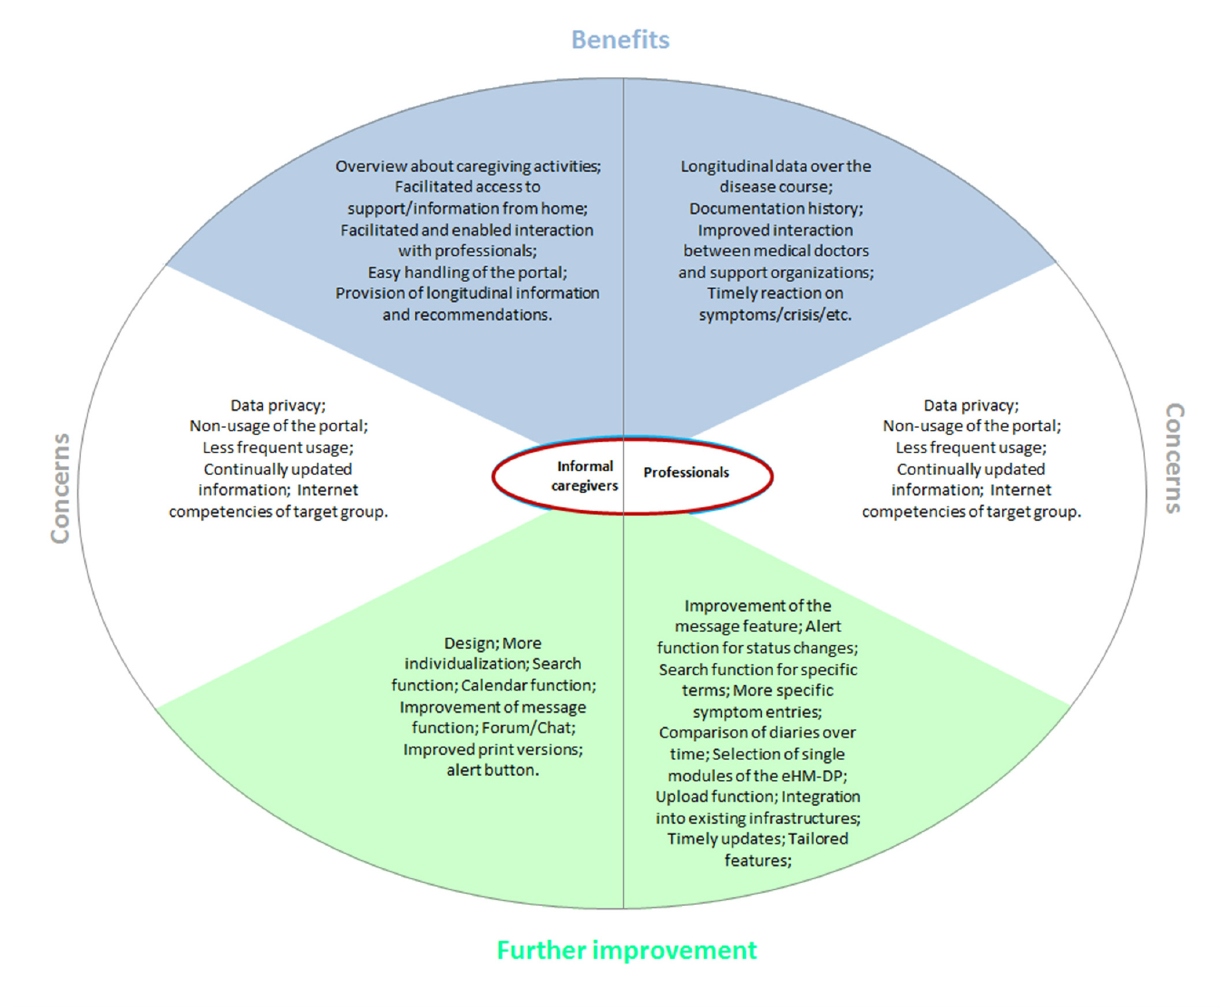
Figure 7. Results of qualitative content analysis: Benefits, concerns,